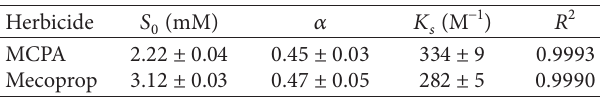
Table 1: Complex formation parameters for MCPA/HP- 𝛽 -CD and mecoprop/HP- 𝛽 -CD systems in water at 25 ∘